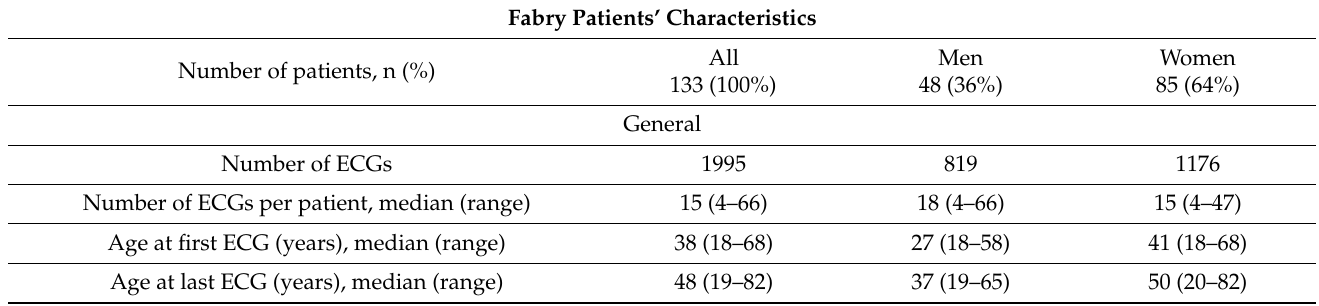
Table 1. Subjects’ characteristics. Fabry Patients’